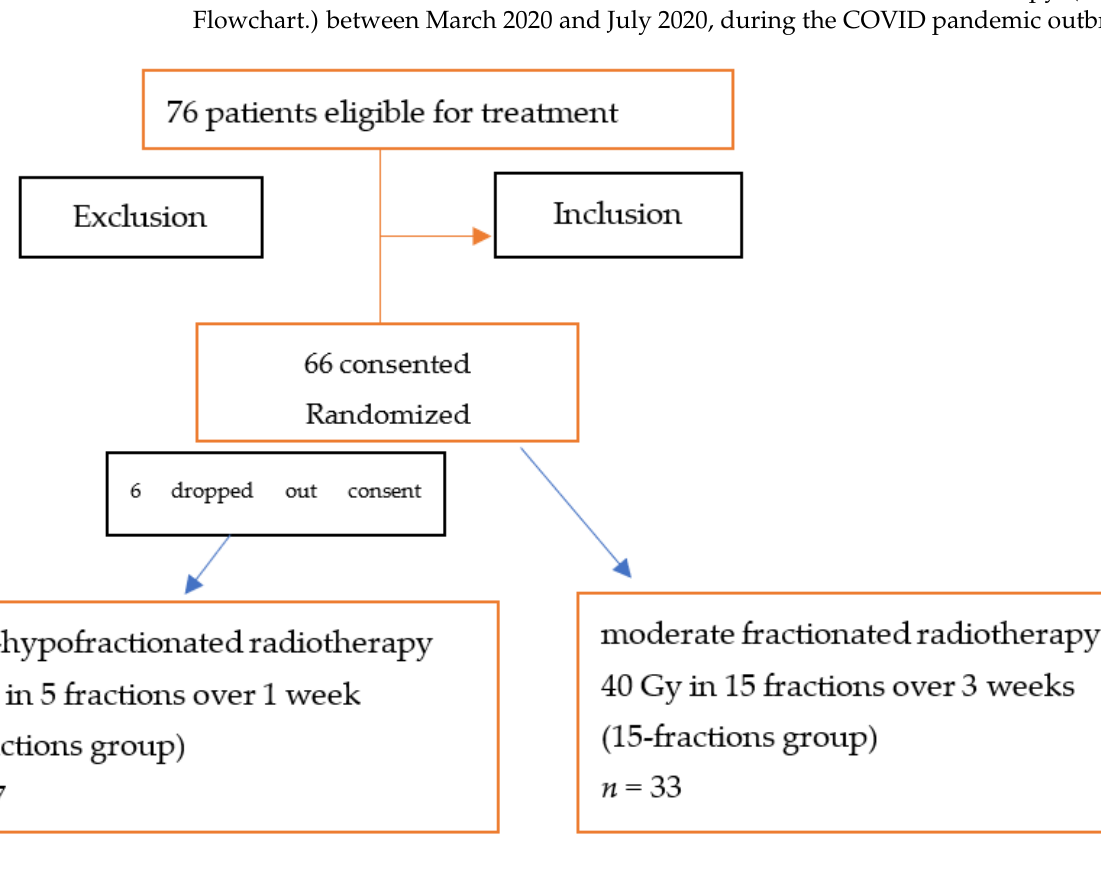
Figure 1. Study flow chart.